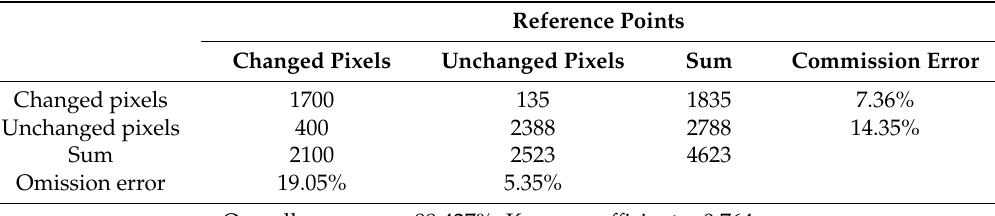
Table 2. The change/no-change detection results.